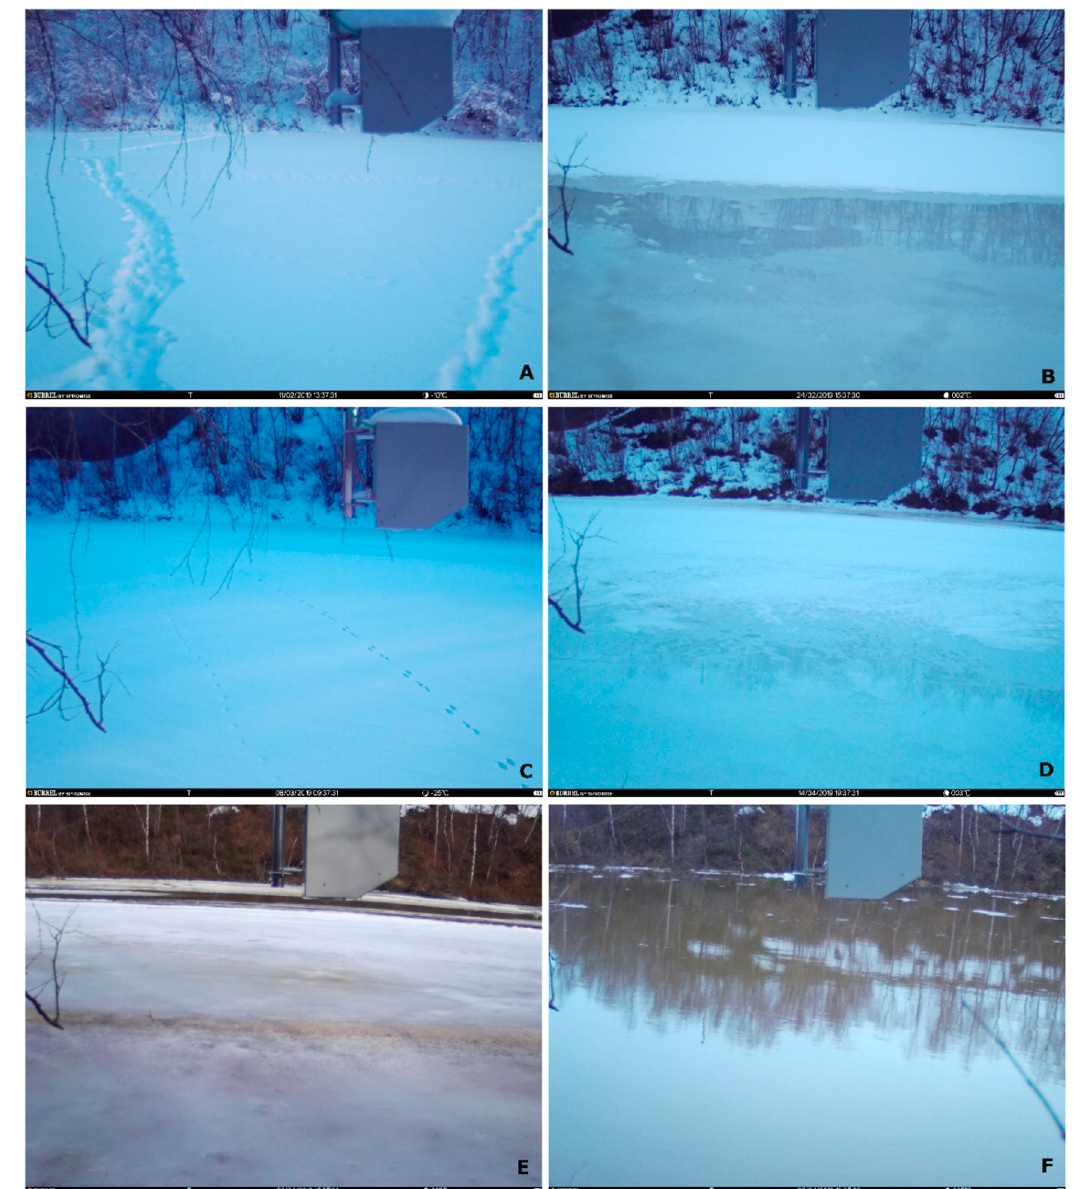
Figure 8. The thawing during spring 2019 as an example of a mechanical ice break-up. The camera has been situated at the HOBO location. ( A ) 11 February 2019: this time step is an example of a solid ice cover situation and cold mid-winter and snowy conditions. ( B ) 24 February 2019: water is flowing on top of the ice. However, there is solid ice cover below. Open-channel conditions must have been somewhere upstream. ( C ) 8 March 2019: before this time step, more snow has fallen and there has been a freezing period. This picture is an example of solid ice conditions during the cold period. This cold and static period lasted until 14.4. ( D ) 14 April 2019: water appears on top of the ice at true-left and true-right banks. Open-channel conditions must have been somewhere upstream. ( E ) 22 April 2019 at 15:37: the ice has risen up along with the water level. The rising started on 20 April 2019 at 15:37 time step. This is the highest the ice has risen before its break-up. There is still similar ice cover two hours later at 17:37. ( F ) 22 April 2019 at 19:37. The mechanical ice-break takes place. The river shows no more ice cover, as only small rafts are floating. Note that the trees / bushes are also lining, i.e., they are no longer standing straight up. The ice and water had peeled of the bark from the trees from c. 1 m height.